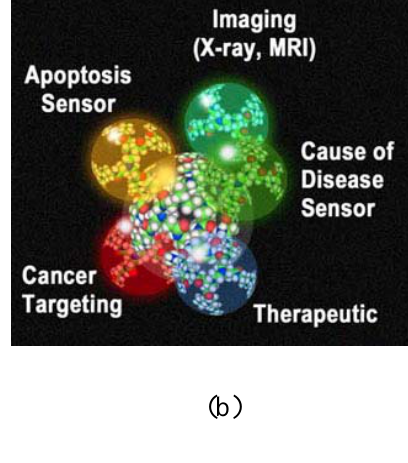
Figure 1 . (a) Structure of generation 3 (G3) polyamidoamine (PAMAM) dendrimer. (b) Schematic of multifunctional PAMAM dendrimer. Images reproduced